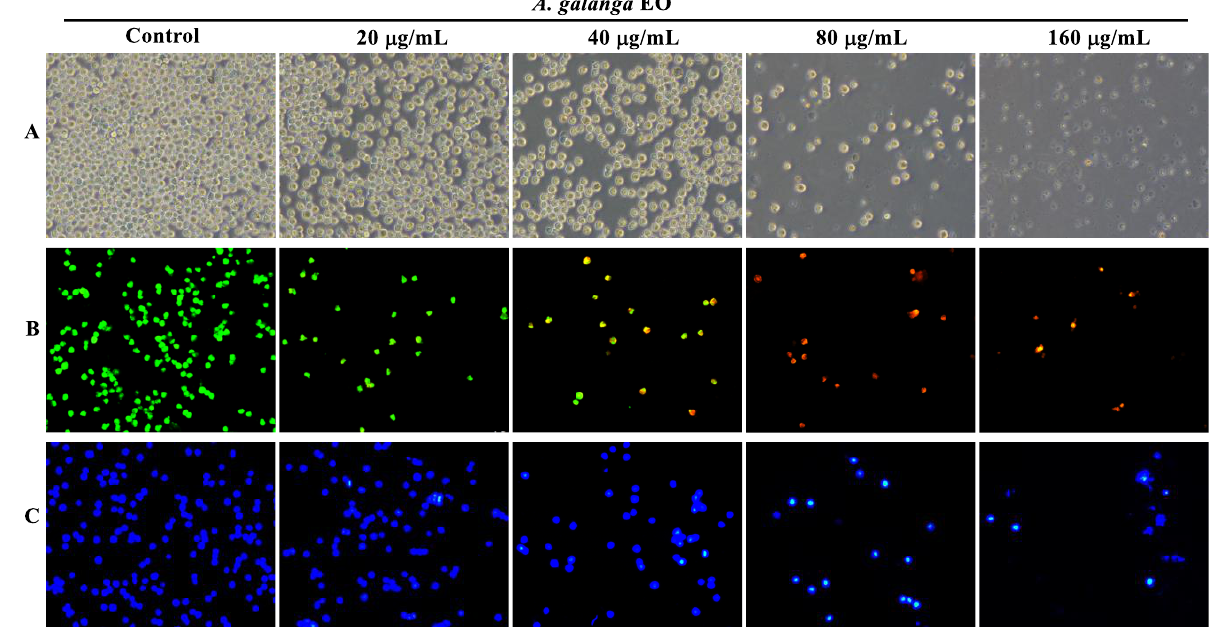
Figure 2. Effect of A. galanga flower essential oil on the morphological changes of K562 cells. ( A ) A phase-contrast microscope was used to observe the morphological alterations of K562 cells (100× magnification). AO/EB staining ( B ) and Hoechst 33,258 staining ( C ) were employed to assess the nuclear morphological alterations of K562 cells, which were viewed under a fluorescence microscope with 100 × magnification.